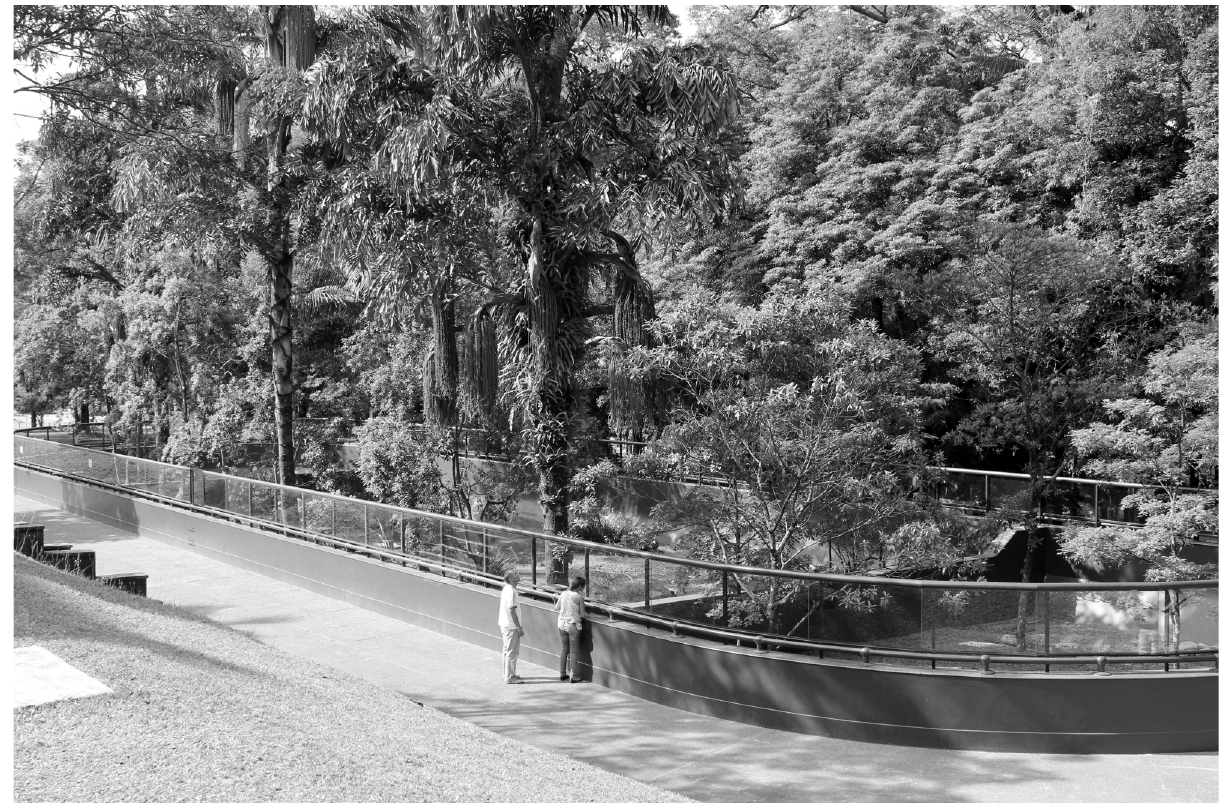
Figure 2 . External view of